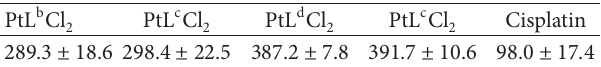
Table 3: IC values ( 𝜇 M) for the water-soluble platinum(II) 50 complexes, cisplatin in BEL7404 cancer cell lines a